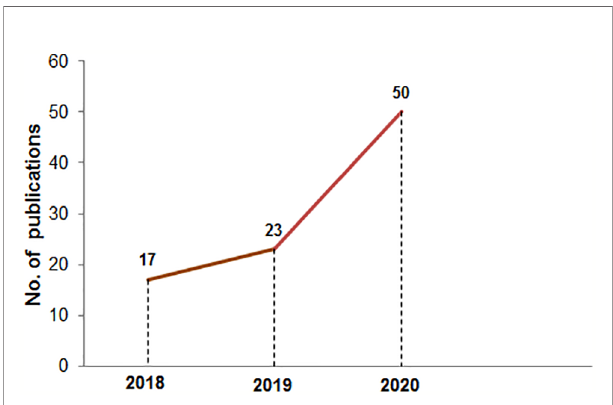
FIGURE 1 | The number of publications in PubMed in the mRNA vaccine area from 2018 to 2020. The PubMed search was performed using the “ mRNA vaccine ” keyword on 10 th Jan